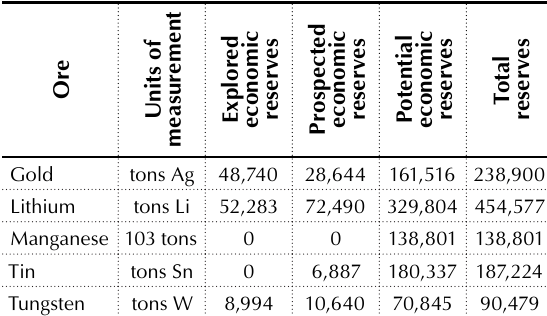
Table 1. Reserves of selected ores as of December 31,